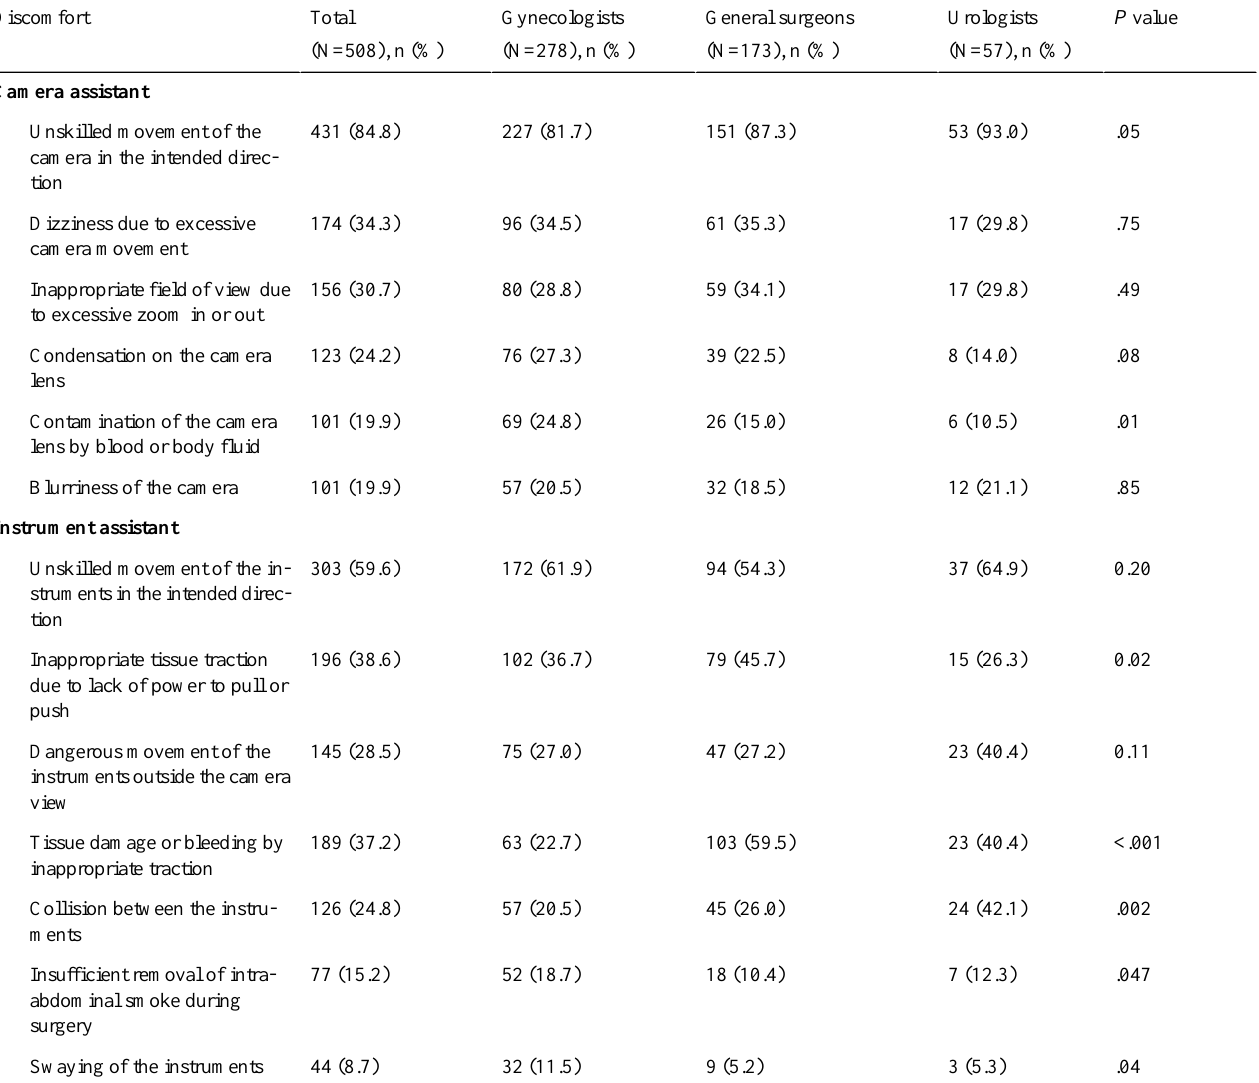
Table 3. Surgeons’discomforts regarding the conventional laparoscopic surgical